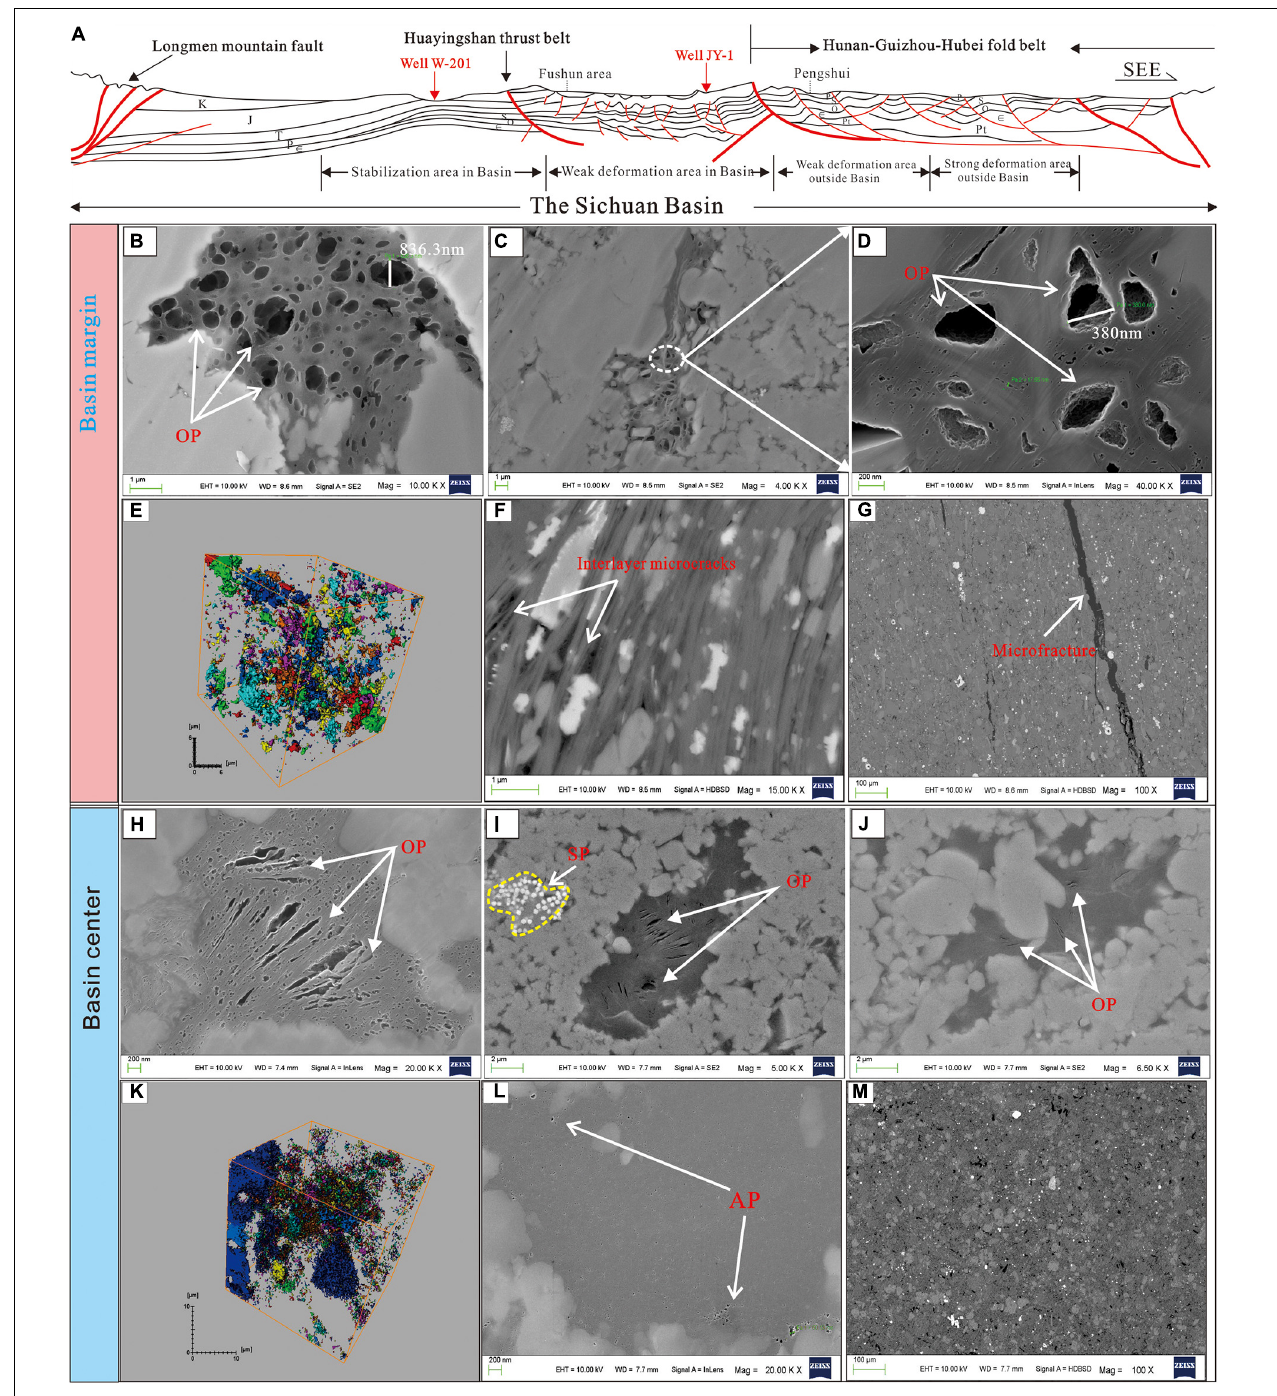
FIGURE 10 | Microscopic characteristics of reservoirs in different structural regions in the Sichuan Basin. (A) Different structural characteristics of the central and marginal areas in the Sichuan Basin. (B) An FESEM image showing the organic pores (OPs), well JY-2, 2,459.36 m. (C) An FESEM image showing the organic pores (OPs), well JY-2, 2,459.36 m. (D) An FESEM image showing the organic pores (OPs), which is a partial enlargement of image (C) , well JY-2, 2,459.36 m. (E) A field emission scanning electron microscope combined with a focused ion beam (FIB-FESEM) image showing the 3-D structure of pore spaces (different colors represent different types of pore spaces), well JY-2, 2,459.36 m. (F) FESEM images showing interlayer micro-cracks, well JY-2, 2,459.36 m. (G) FESEM images showing a micro-fracture of shale, well JY-2, 2,459.36 m. (H) An FESEM image showing the organic pores (OPs), well N-203, 2,325.64 m. (I) An FESEM image showing the organic pores (OPs) and strawberry pyrite (SP), well W-201, 2,678.61 m. (J) An FESEM image showing the organic pores (OPs), well W-201, 2,678.61 m. (K) An FIB-FESEM image showing the 3-D structure of pore spaces (different colors represent different types of pore spaces), well W-201, 2,678.61 m. (L) An FESEM image showing intragranular pore spaces (APs), well W-201, 2,678.61 m. (M) An FESEM image of the overall micro-characteristics of shale, well W-201, 2,678.61 m.